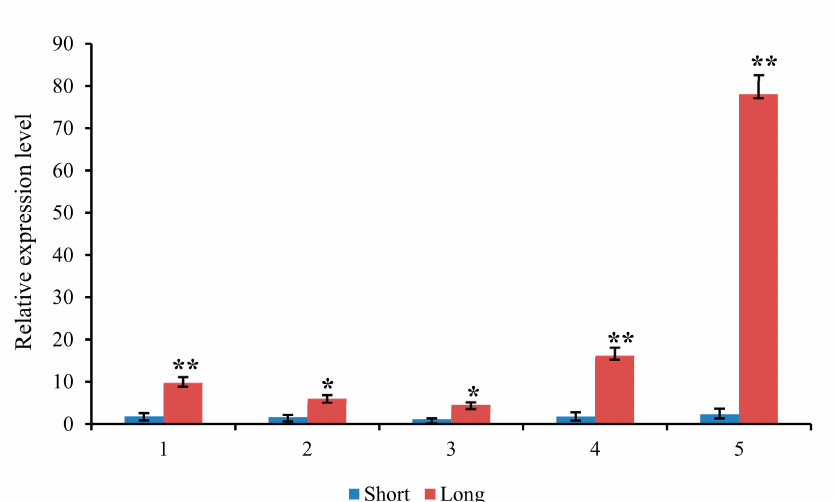
Figure 5. Expression analysis of five candidate genes. Relative expressions of the five genes in long- and short -mesocotyl length rice accessions were tested by qRT-PCR. Transcription levels were normalized to that of Osactin1 and compared to the short control. 1 to 5 represent five candidate genes, that is 1, LOC_Os05g10670 ; 2, LOC_Os05g10770 ; 3, LOC_Os09g03140 ; 4, LOC_Os12g08780 ; 5, LOC_Os12g24800 . Values of fold change are showed in mean ± SEM. Relative transcription levels were calculated by the log2 - (cid:52)(cid:52) CT method. * and ** indicate the significance at p ≤ 0.05 and p ≤ 0.01,